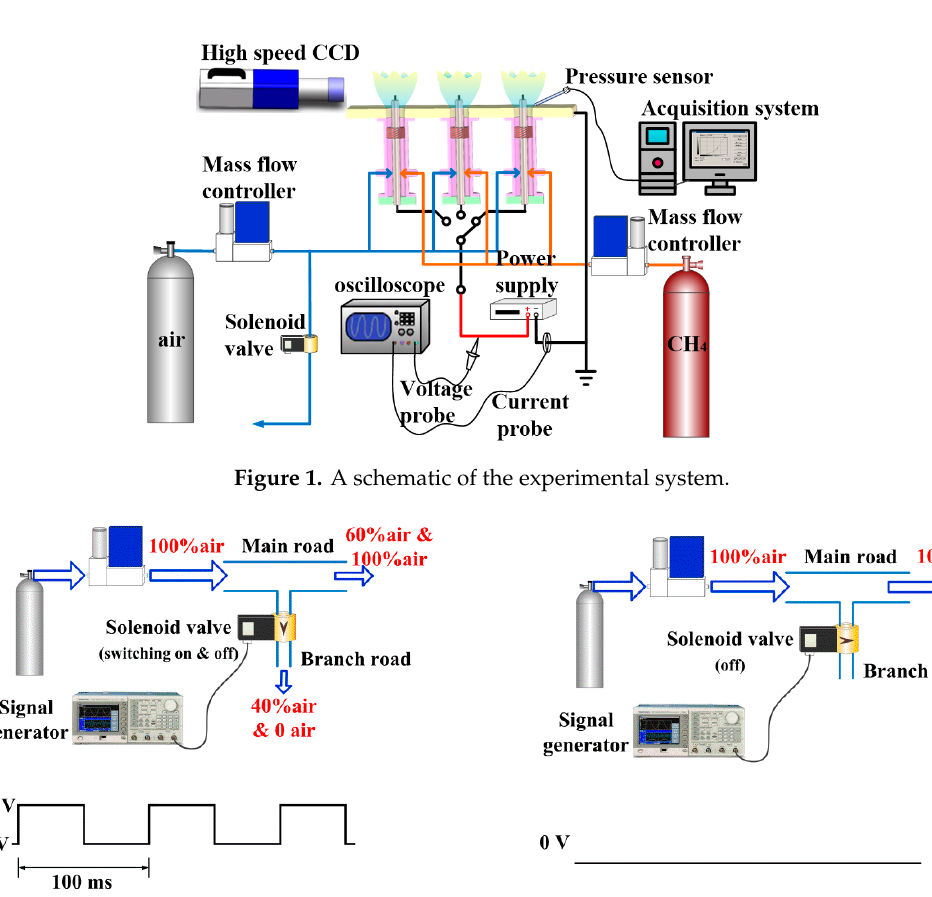
Figure 2. The working progress of pulsating air flow generator ( a ) in pulsating flow mode, and ( b ) in stable flow mode.